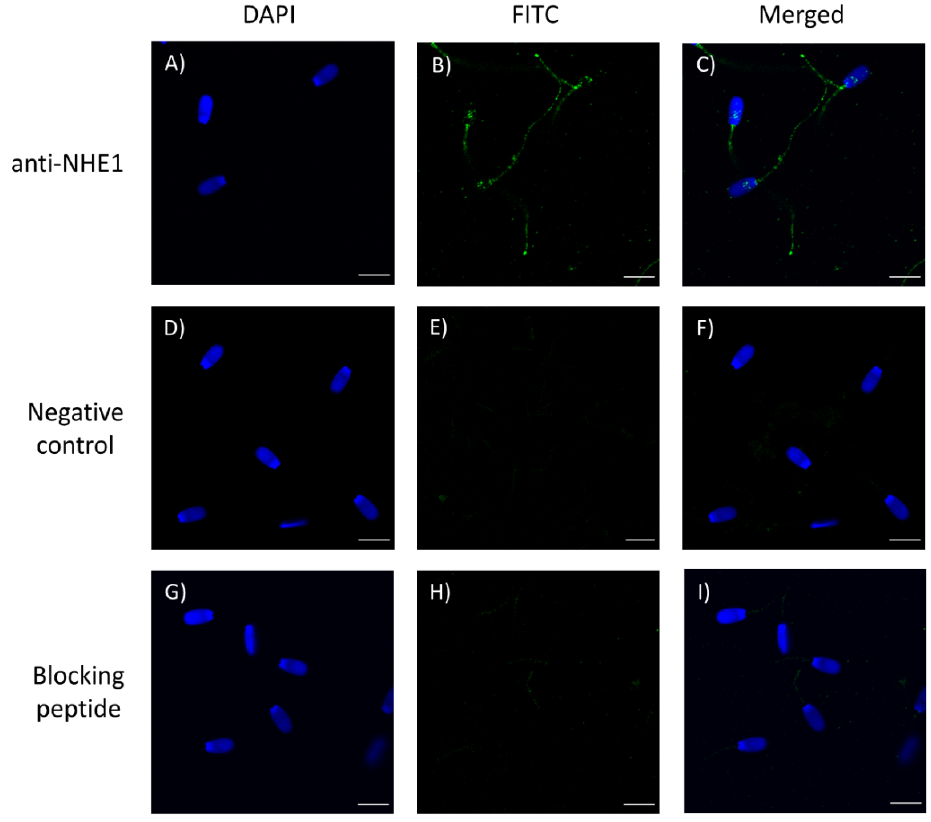
Figure 2. Immunolocalization of NHE1 in the sperm plasma membrane ( A – C ), negative control ( D – F ), and after the peptide competition assay ( G – H ). NHE1 appears stained in green (FITC; fluorescein isothiocyanate) and nuclei are in blue (DAPI; 4 ′ 6 ′ -diamidion-2-phenylindole). Scale bar: 9 µm.